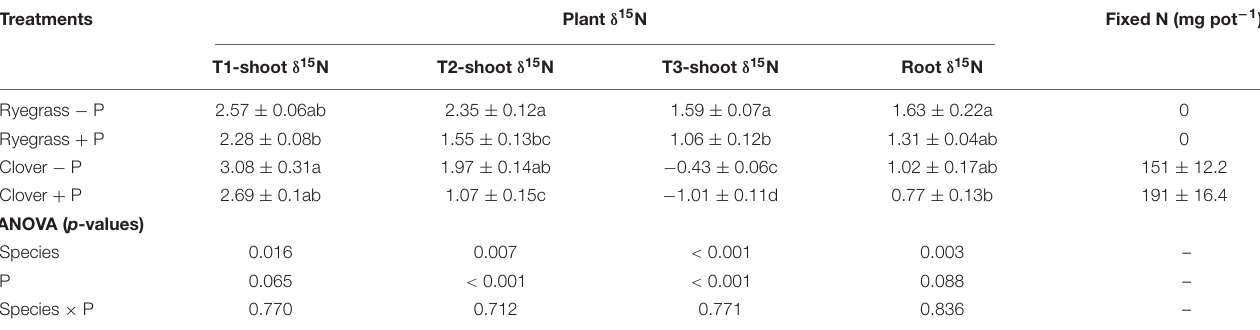
TABLE 2 | Plant δ 15 N values in shoot and root biomass of ryegrass and clover, and biologically fixed N in clover with and without P fertilization (T1, Day 30; T2, Day 44; T3, Day 58).